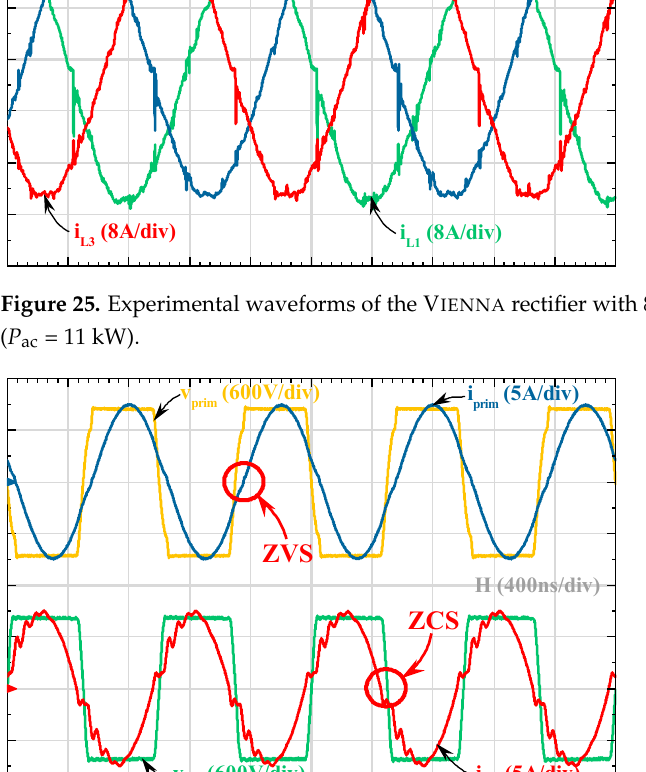
Figure 24. Breakdown of the system components according to their contribution to ( a ) the volume of the charger of 4.85 L and ( b ) the mass of the charger of 5.78 kg. The testing waveforms of the V IENNA rectifier with the 800 V battery voltage and full load are shown in Figure 25, where I La , I Lb , and I Lc are the mains ’ input currents of L a , L b , and L c (cf. Figure 2 or Figure 21). At full load, a power factor of 0.99 and a total harmonic distortion of the mains current of 3.8% is achieved. The harmonic current limits, defined in DIN EN 61000-2, are met up to the 40th harmonic.